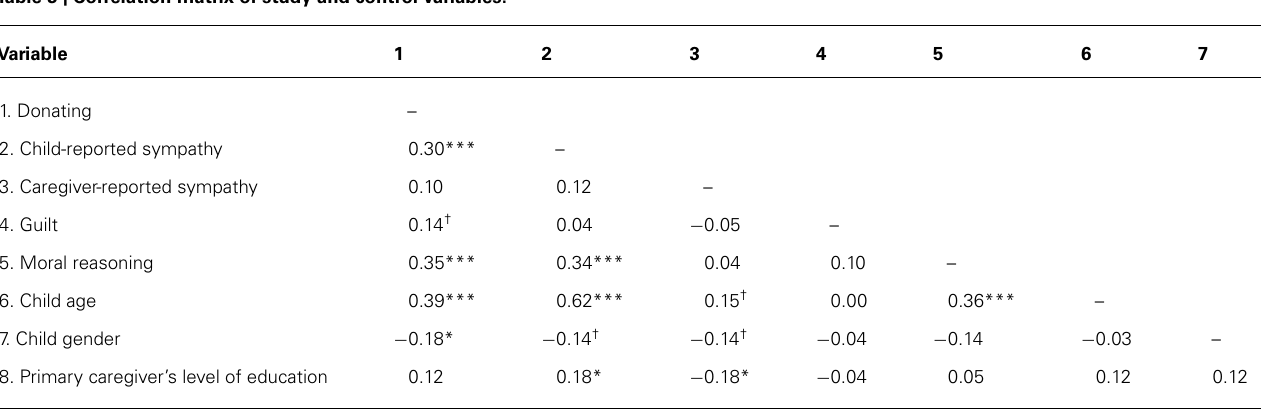
Table 3 | Correlation matrix of study and control